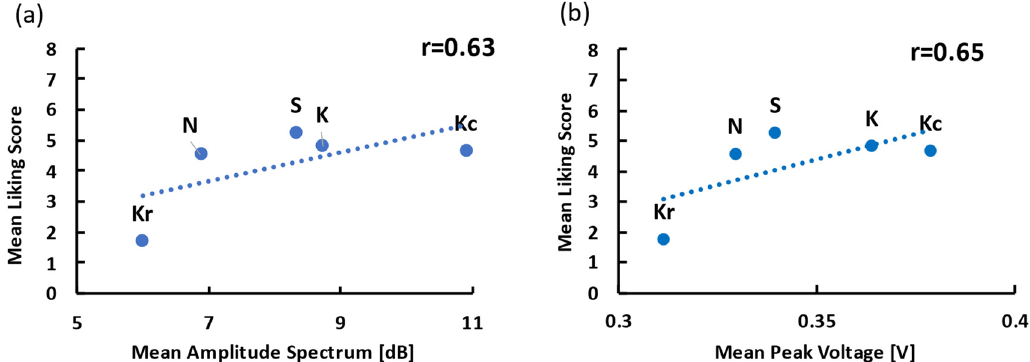
Figure 11. The relationships between the physiological index and the liking score. ( a ) Scatterplot of the mean amplitude spectrum and the mean liking score. ( b ) Scatterplot of the mean peak voltage and the mean liking score. Samples S, K, and N are available commercially and produced by different manufactures. Sample Kr was a moisturized and re-dried version of K, and Kc was a crushed version of K.